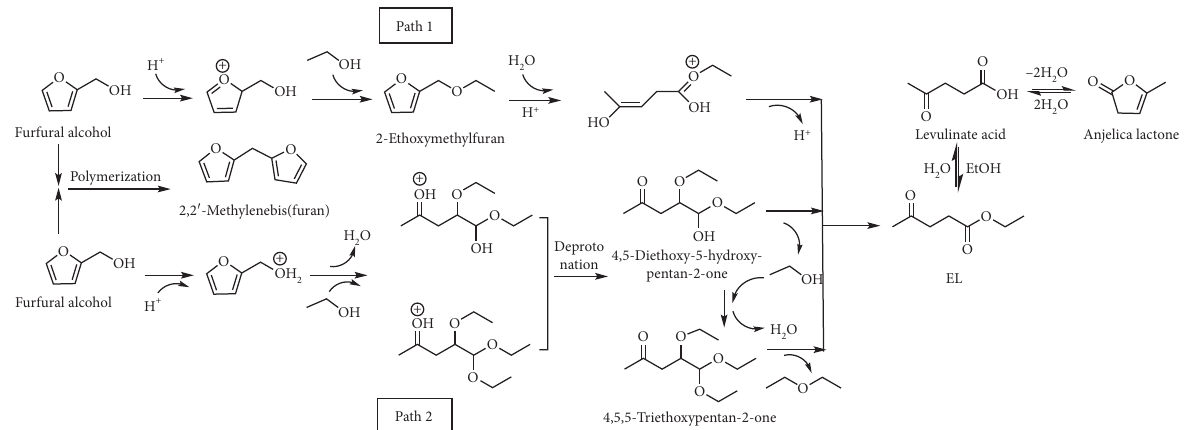
Scheme 1: Proposed mechanism for the transformation of furfuryl alcohol to ethyl levulinate in